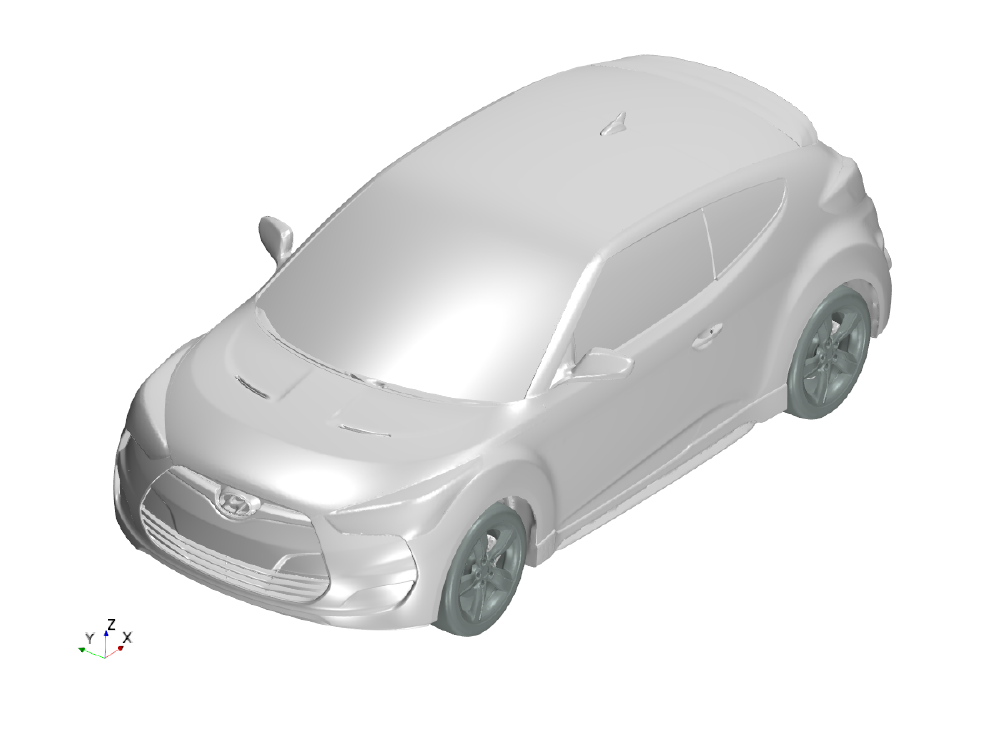
Figure 1. Full vehicle